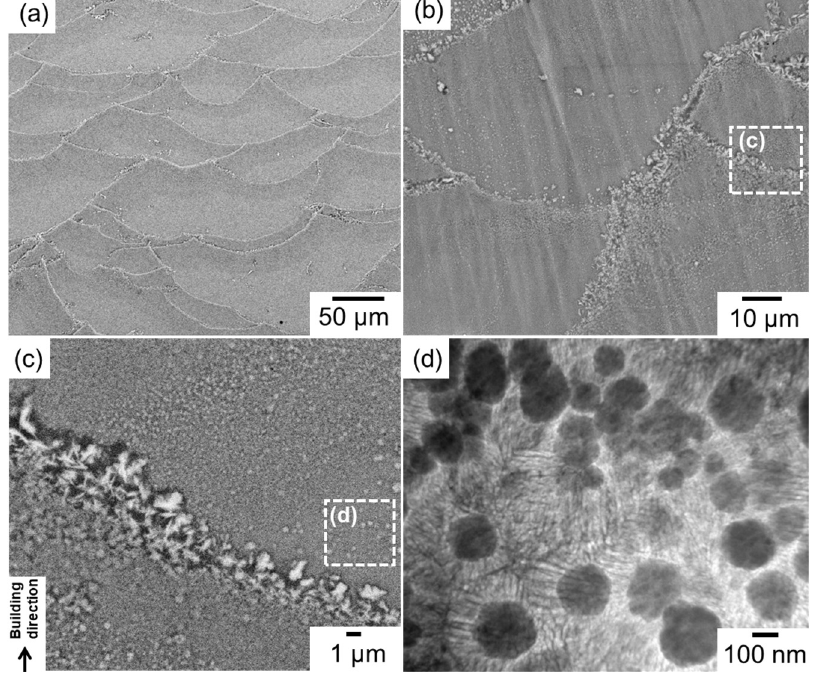
Figure 1. ( a – c ) SEM images showing microstructures of L-PBF-constructed Al–15%Fe alloy: ( a , b ) low-magnification views and ( c ) a location around the melt-pool boundary. ( d ) Bright-field TEM image showing spherical Al 6 Fe-phase particles surrounded by nanoscale cellular structures in the melt